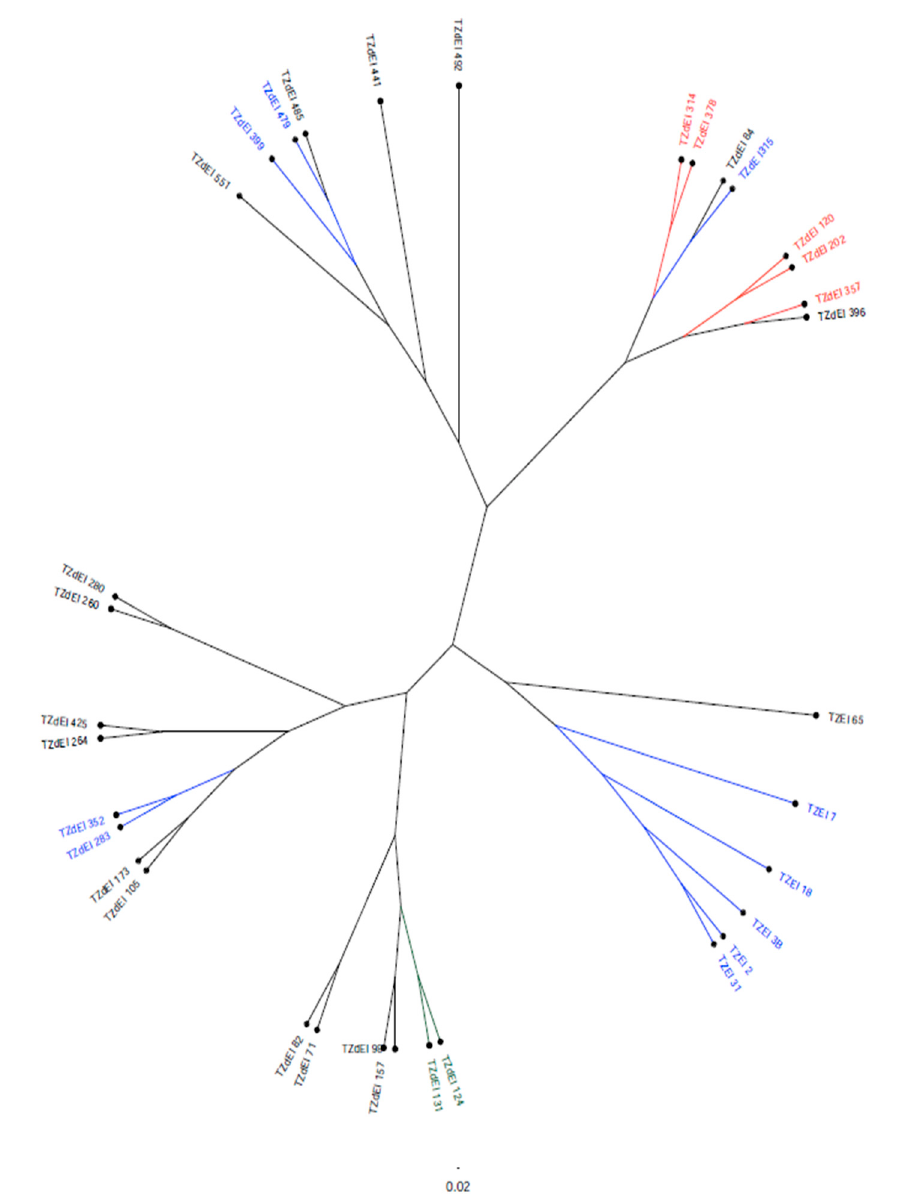
Figure 2. Phylogenetic tree of the 34 inbred lines based on Nei’s genetic distance estimated from 4440 SNP markers. The sub-populations I, II and III obtained by STRUCTURE are represented by red, green and blue colours, respectively. Black color represents admixture inbreds.